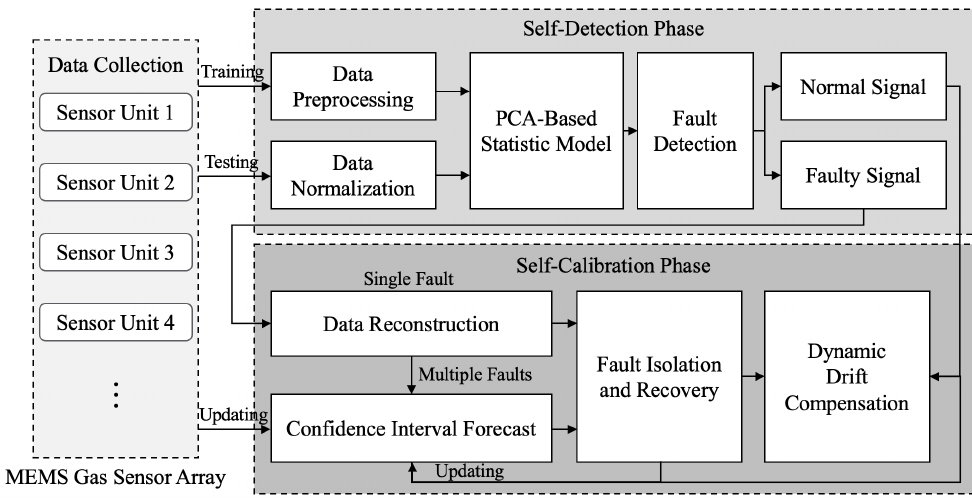
Figure 1. Overall process of Self-Detection and Self-Calibration strategy.